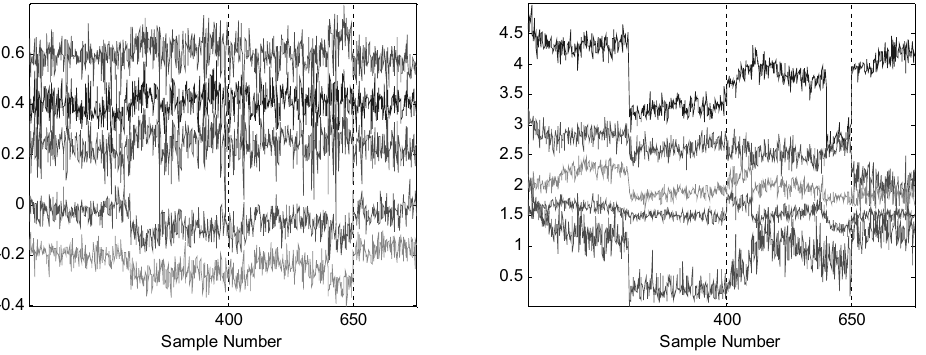
Fig. 3. Five selected AR coefficients (left) and absolute transmissibilities (right). Damage location 1.